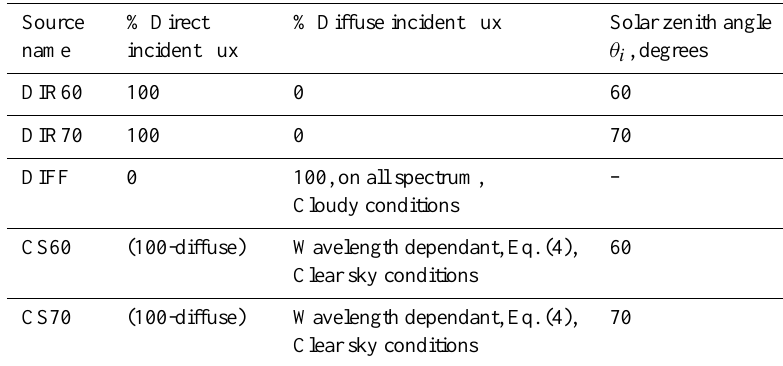
Table 2. Name and type of incident light sources used in the DISORT calculations.